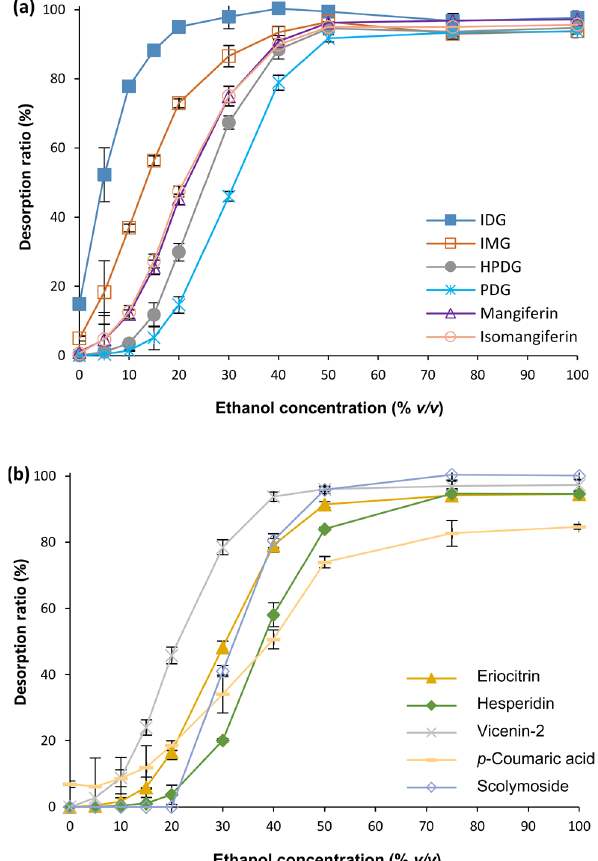
Figure 1. Desorption ratios of Cyclopia subternata benzophenones, dihydrochalcones and xanthones ( a ) and flavanones, flavones and a phenolic acid ( b ) on XAD 1180N macroporous resin as a function of ethanol concentration (% v / v ), using static desorption. Data are given as mean ± standard deviation (n = 3). Abbreviations: IDG, 3- β - D -glucopyranosyl-4- O - β - D -glucopyranosyliriflophenone; IMG, 3- β -d-glucopyranosyliriflophenone; HPDG, 3 ′ ,5 ′ -di- β - D -glucopyranosyl-3-hydroxyphloretin; PDG, 3 ′ ,5 ′ -di- β - D -glucopyranosylphloretin.